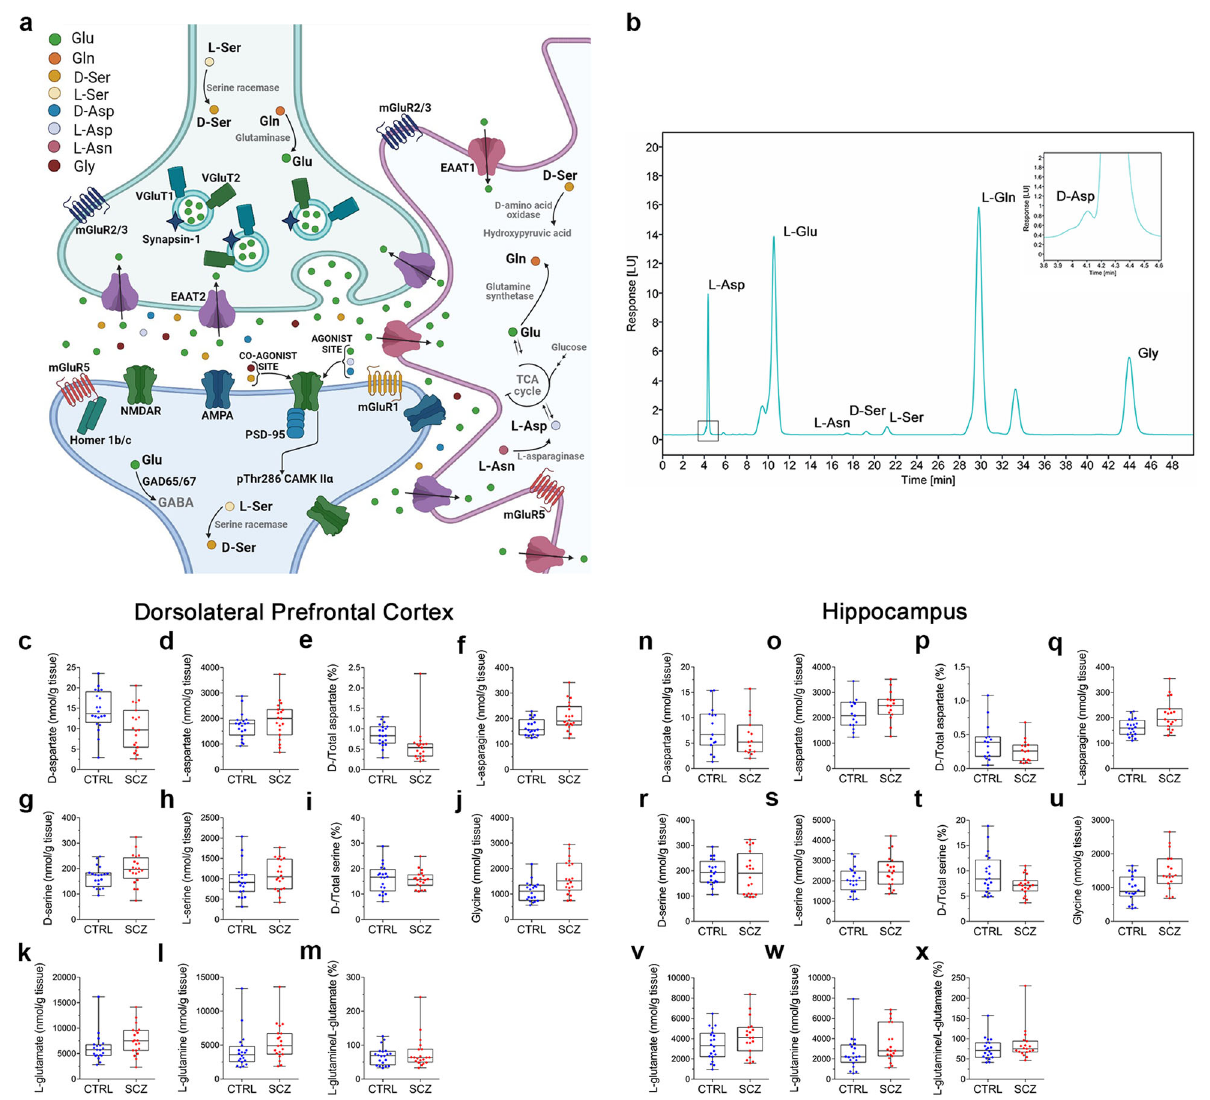
Fig. 1 Analysis of D -aspartate, L -aspartate, D -serine, L -serine, L -asparagine, L -glutamate, L -glutamine and glycine levels in the post-mortem dorsolateral prefrontal cortex and hippocampus of schizophrenia patients and control subjects. a Schematic model of the tripartite glutamatergic synapse showing the main localization of the molecules analyzed in this study. Image created with BioRender.com (www. biorender.com). b Representative HPLC chromatogram showing D -aspartate ( D -Asp), L -aspartate ( L -Asp), L -glutamate ( L -Glu), L -asparagine ( L -Asn), D -serine ( D -Ser), L -serine ( L -Ser), L -Glutamine ( L -Gln) and glycine (Gly) peaks obtained from non-psychiatric human DLPFC homogenate. c – x Content of c , n D -aspartate, d , o L -aspartate, e , p D -aspartate/total aspartate ratio, f , q L -asparagine, g , r D -serine, h , s L -serine, i , t D -serine/ total serine ratio, j , u glycine, k , v L -glutamate, l , w L -glutamine levels and m , x L -glutamine/ L -glutamate evaluated in the post-mortem c – m dorsolateral prefrontal cortex (DLPFC) and n – x hippocampus, compared between controls (CTRL) and patients with schizophrenia (SCZ). In each sample, all the amino acids were detected in a single run by HPLC and expressed as nmol/g of tissue, while the ratios are expressed as percentage (%). The number of examined samples is reported in Table 2, for each considered amino